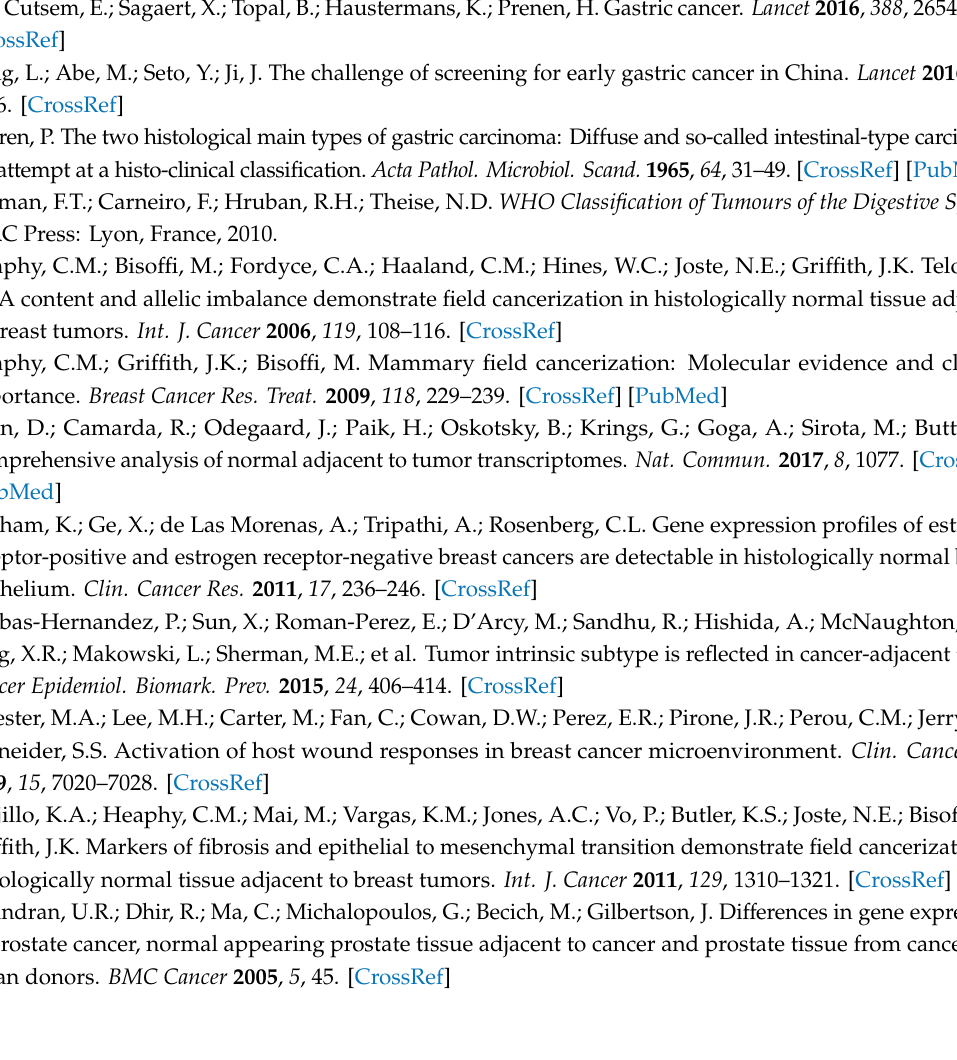
the overlap between GC vs. gNAT vs. GC vs. normal, Figure S10: gene set analysis (GSA) of the GO categories using the DEGs between tumor or gNAT vs. each of the other 2 tissues, respectively. Adjusted p-value in red-blue color scale. Gene ratio in dot size scale. Red, blue and green arrows highlight interesting exclusive and common gene sets, respectively. (A) Tumor centered analysis, (B) gNAT centered analysis, Figure S11: Association of the histological grade with hallmark early and late ER pathways activity in gNAT and GC, Figure S12: Association of JGCA anatomical part (A) and gender (B) with hallmark early and late ER pathways activity in gNAT and GC, Figure S13: Association of therapy tissue type and grade with hallmark late ER pathway activity according to gender (A) or JCGA anatomical site (B), respectively, Figure S14: multidimensional scaling plot of the RNA samples in which distances correspond to leading log-fold-changes between each pair of RNA samples. GC in purple, gNAT in orange, labels represents the name of the samples, Table S1: Summary of the di ff erentially expressed genes among adjacent, normal and tumor samples., Data S1: TCGA DEGs tumor vs. adjacent vs. normal, Data S2: Enriched hallmark in TCGA gNAT, Data S3: univariate analysis of the most interesting clinical variables (grade, TNM, anatomic positions, etc.) on the TCGA data, Data S4: inHouse DEGs in GC vs. gNAT, Data S5: digital PCR